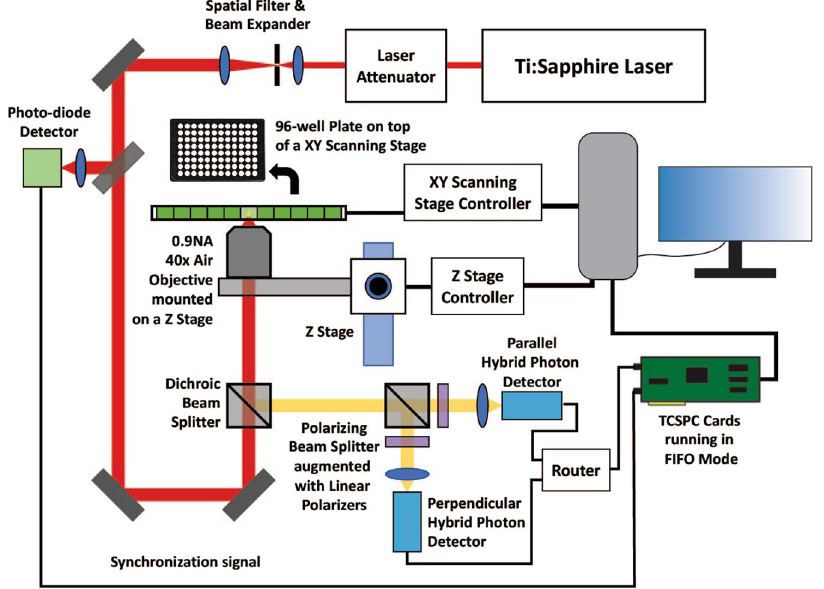
Figure 1. Auto-FPFA schematic. The light path and components used for implementing auto-FPFA. Key components that have been added or modified from previous implementations of FPFA include the integration of a XY-dual axis scanning stage controller, a Z-axis stage controller, and the use of a 0.9 NA 40x air